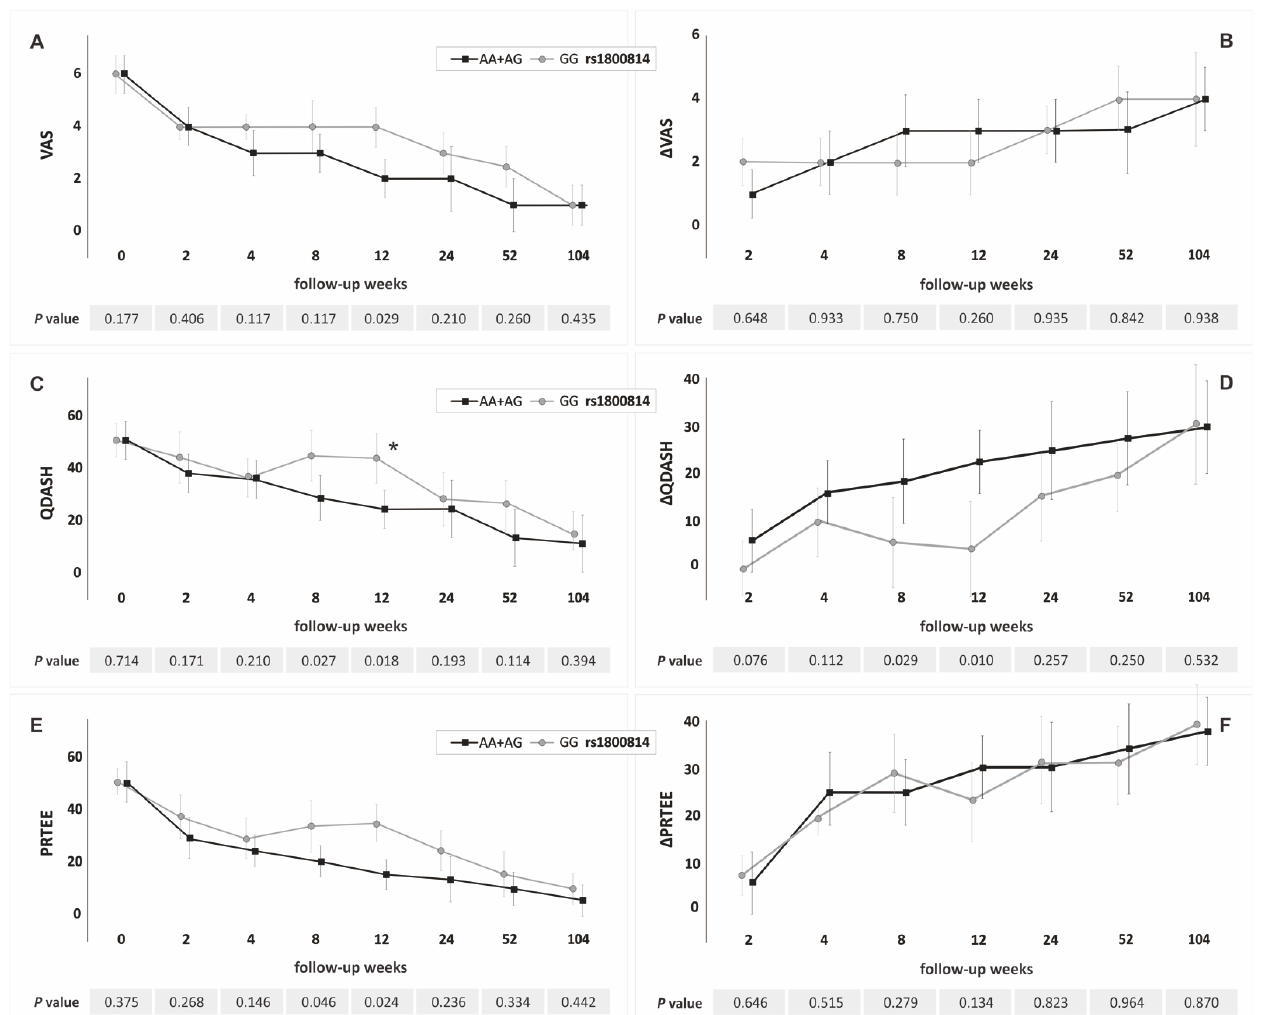
Figure 2. Medians (± QD) of PROMs values in respect to genotype variants of the PDGFA gene rs1800814 polymorphism (recessive/dominant model): ( A ) for VAS; ( B ) for ΔVAS; ( C ) for QDASH; ( D ) for ΔQDASH; ( E ) for PRTEE; ( F ) for ΔPRTEE. * Statistically important differences ( p < 0.050) in the percentage of patients who exceeded minimally clinically important difference (MCID). Legend: QD, quartile deviation; PROM, patient-reported outcome measure; VAS, visual analog scale; QDASH, quick version of disabilities of the arm, shoulder and hand score; PRTEE, patient-rated tennis elbow evaluation.